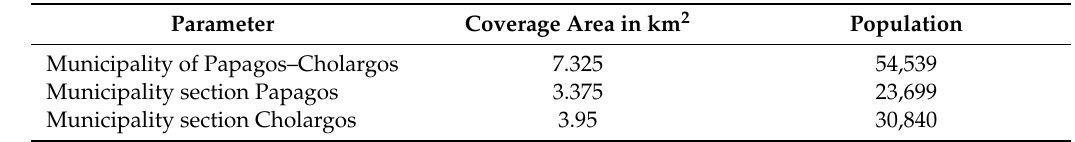
Table 7. Municipality parameters.